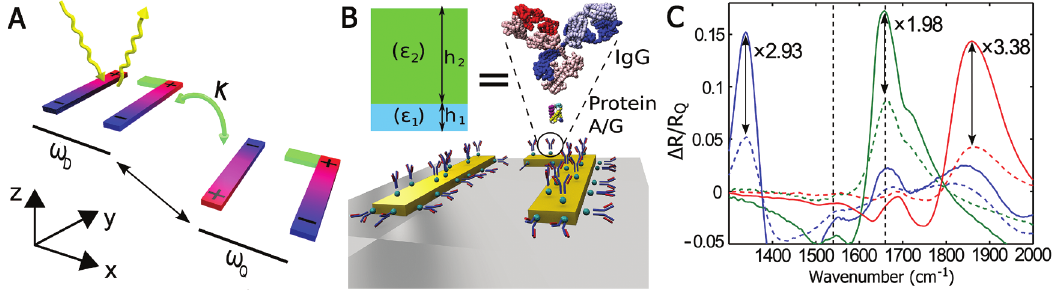
) and subradiant D